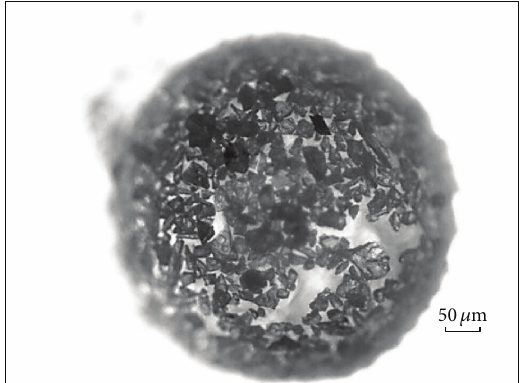
Figure 8: Microbubble with adhering sphalerite (treated with ACS and SIBX).